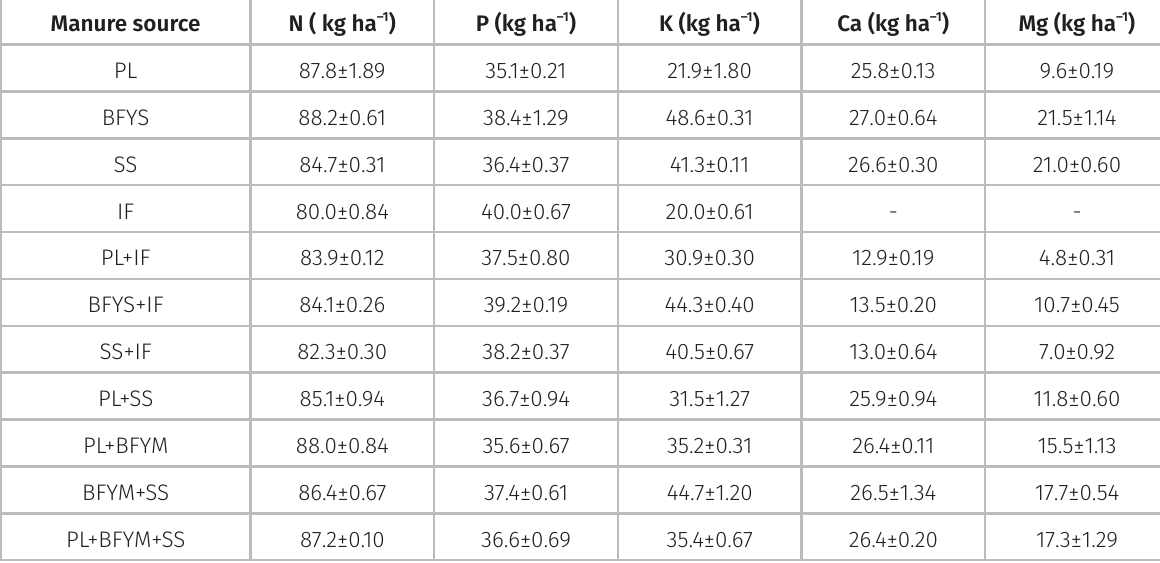
Table III. The total amount of nutrients supplied through different sources and their combinations after